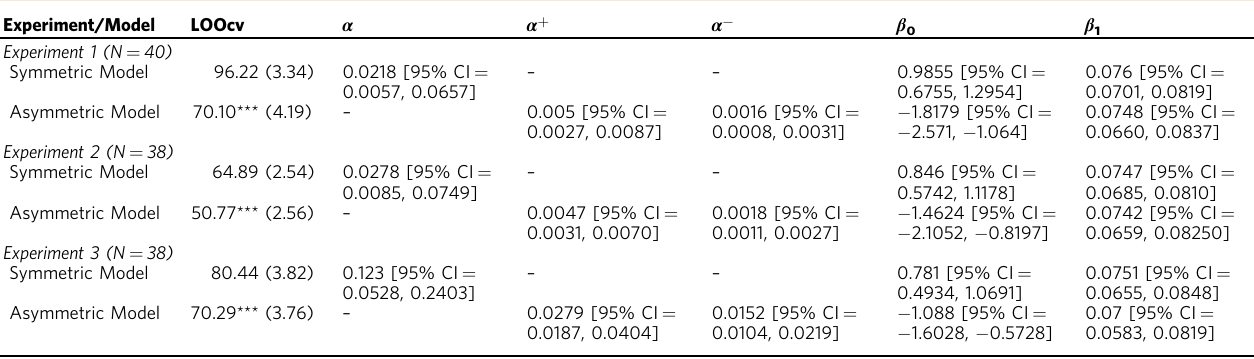
The table summarizes for each model its fi tting performances and its average parameters: LOOcv: Leave One Out cross-validation scores, mean (standard error of the mean) over participants, lower LOOcv scores indicate better performance; α : learning rate for both positive and negative prediction errors (Symmetric Model); α + : learning rate for positive prediction errors; α − : average learning rate for negative prediction errors (Asymmetric Model); β 0 : softmax intercept (bias towards reject); β 1 : softmax slope (sensitivity to the difference in the value of rejecting versus the value of accepting an option). Data for model parameters are expressed as mean and 95% con fi dence intervals (calculated as the sample mean±1.96×standard error). *** P <0.001 comparing LOOcv scores between the two models, two tailed paired sample t -test (Experiment 1: t (39) = 7.20, p = 1.1551E − 8; Experiment 2: t (37) = 6.04, p = 5.4824E − 7; Experiment 3: t (37) = 5.47, p = 0.000003). Source data are provided as a Source Data fi